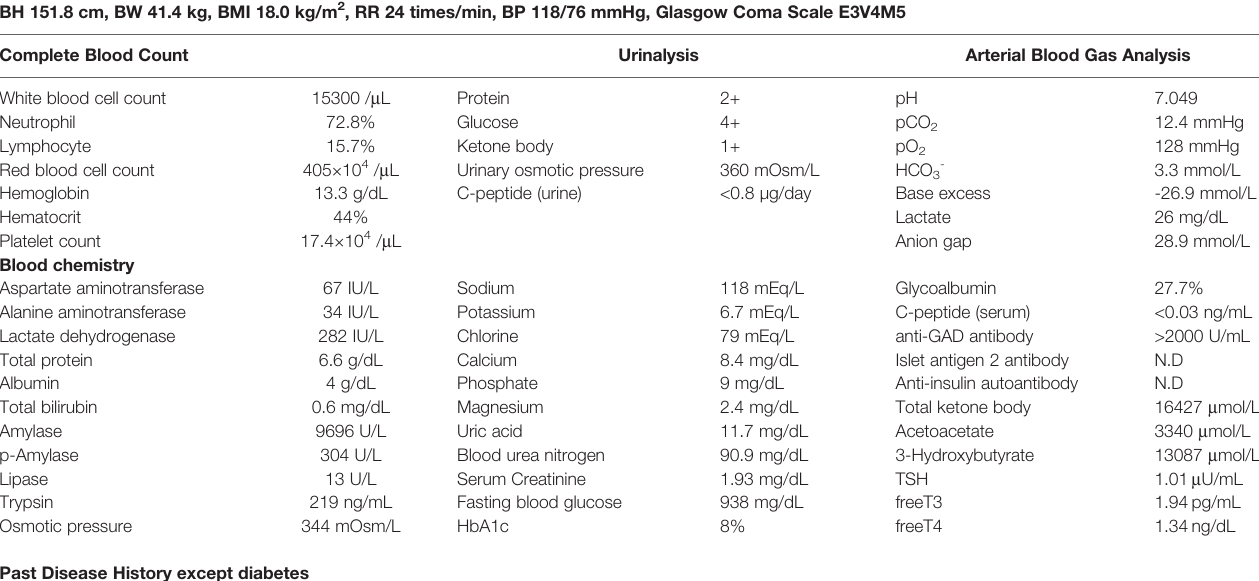
TABLE 1 | The patient ’ s physical examinations and laboratory data on admission. Physical